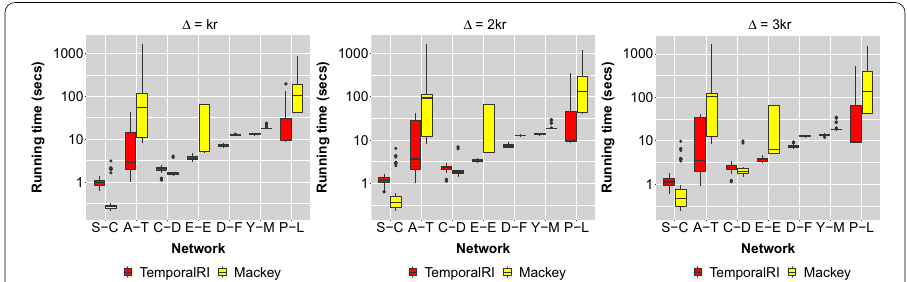
Fig. 5 Comparison between TemporalRI and Mackey’s algorithm on the set of queries with k = 3 contacts on varying (cid:31) . Boxplots of running times are built on the set of experiments in which both algorithms ended before the timeout. Network names are abbreviated